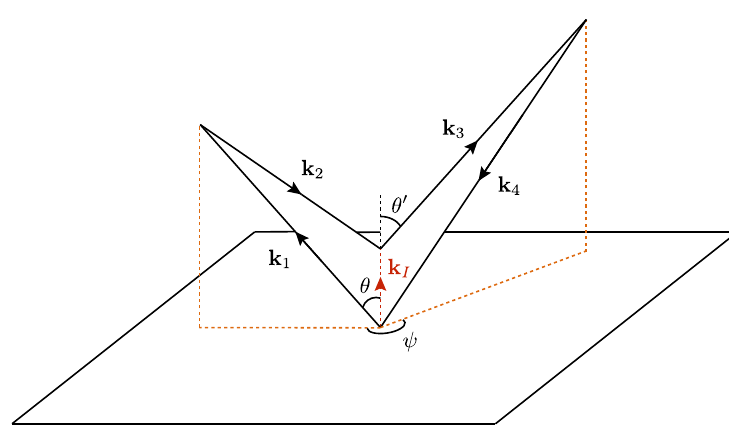
Figure 4 . Sketch of the trispectrum in the collapsed con(cid:12)guration. The information on the spin of the exchanged (partially) massless (cid:12)eld is contained in the ( (cid:18); (cid:18) 0 ; ) dependence of the